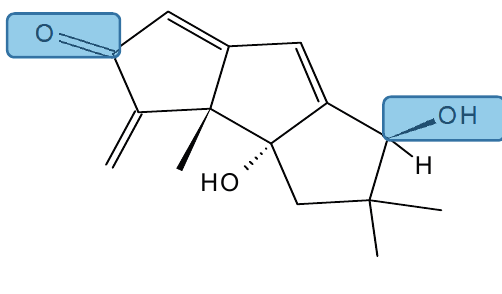
Figure 46. Hirsutanol A ( 132 ).